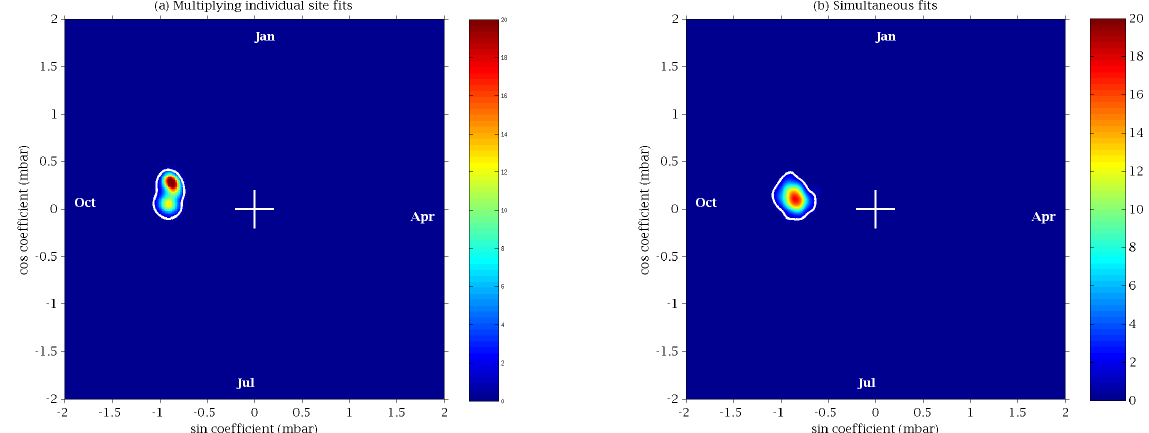
Figure 8. (a) The probability of the annual mass having a given amplitude and phase for all 17 sites, combining individual site fits, renor- malised to integrate to 1. (b) Scatter of annual amplitude and phase for all sites simultaneously, with noise added to the bottom-pressure records. Both plots are for the ECCO model, with GLDAS-1. 95% of results fall inside the white